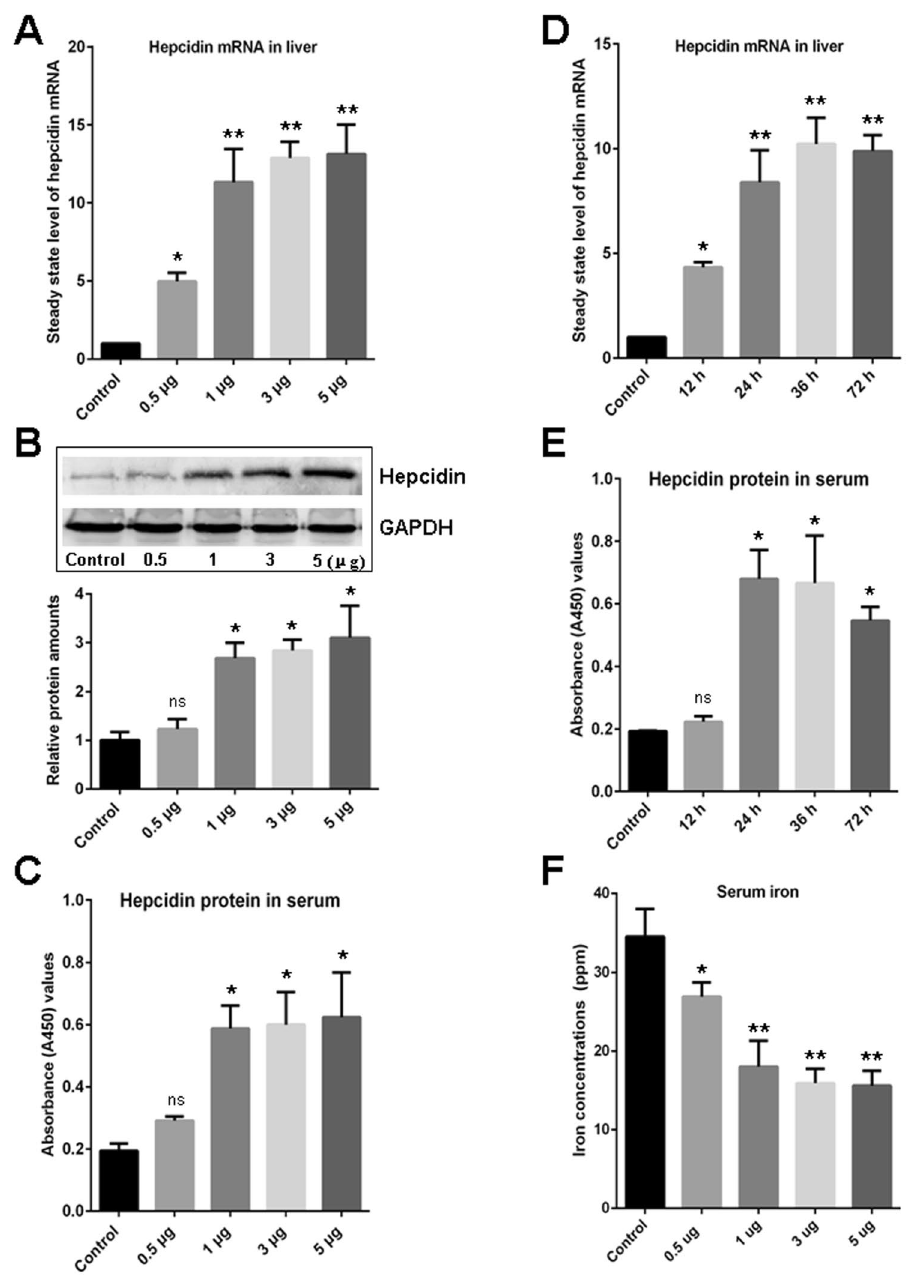
Figure 1. Evaluation of the induced expression of hepcidin and reduced serum iron concentration upon A. hydrophila DNA stimulation. ( A ) Detection of the steady state level of hepcidin mRNA in liver upon stimulation with various concentrations of A. hydrophila DNA (0.5, 1, 3, and 5 μ g per fish) by Q-PCR. ( B and C ) Detection of the hepcidin protein level in serum upon stimulation with various concentrations of A. hydrophila DNA (0.5, 1, 3, and 5 μ g per fish) by Western blot ( B ) and ELISA ( C ), and the gray value of the relative signal intensity (hepcidin/GAPDH) in Western blot analysis was calculated using ImageJ program and depicted in a bar graph. ( D ) Time-dependent upregulation of the steady state level of hepcidin mRNA in liver upon stimulation with A. hydrophila DNA (1 μ g per fish) as determined by Q-PCR. ( E ) Time-dependent upregulation of the hepcidin protein in serum upon stimulation with A. hydrophila DNA (1 μ g per fish) as determined by ELISA. ( F ) Reduced concentrations of serum iron stimulated by A. hydrophila DNA (0.5, 1, 3, and 5 μ g per fish) were detected by ICP-MS. The control groups in each experiment (indicated as Control) received mock PBS. The steady state level of hepcidin mRNA in liver was calculated by 2 −ΔΔ CT method normalized to β -actin. All data are representative of at least three independent experiments. A significant difference was detected between each experimental and control group. * p < 0.05, ** p < 0.01. ns for not significant. The full-length blots are presented in Supplementary Fig.